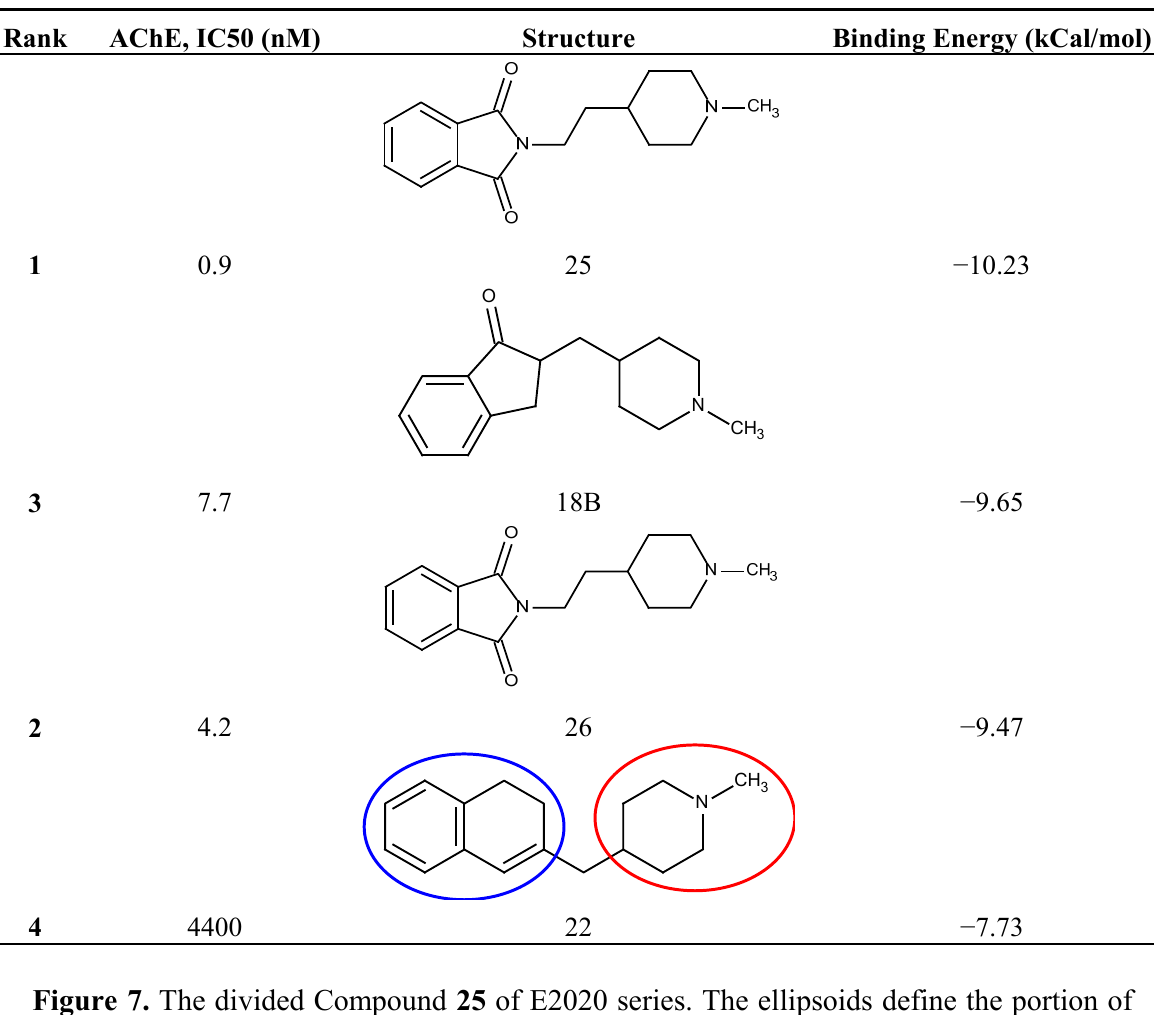
Table 4. Ranking of E2020 series after optimization. The ellipses define fragments of for each site in Compound 22 ; blue for fragment 1 and red for fragment 2.